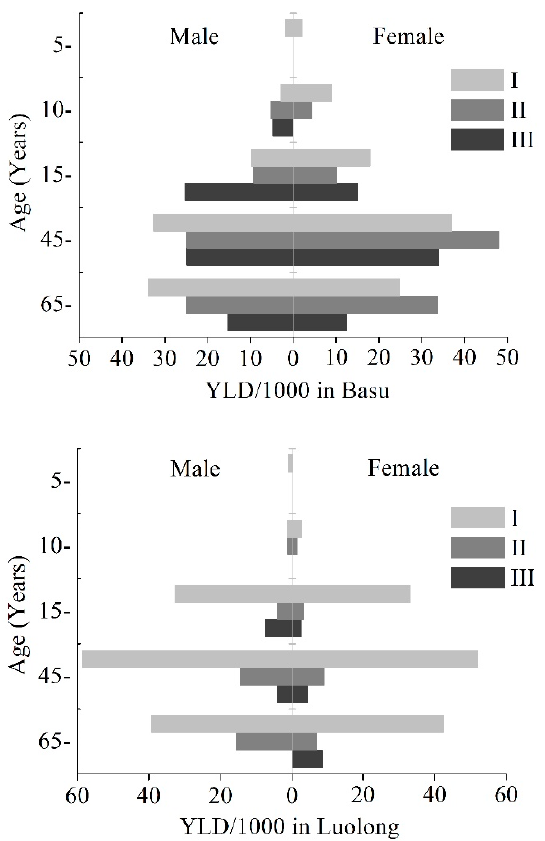
Figure 2. Age-specific YLD rate by gender and KBD grades in Basu and Luolong County.